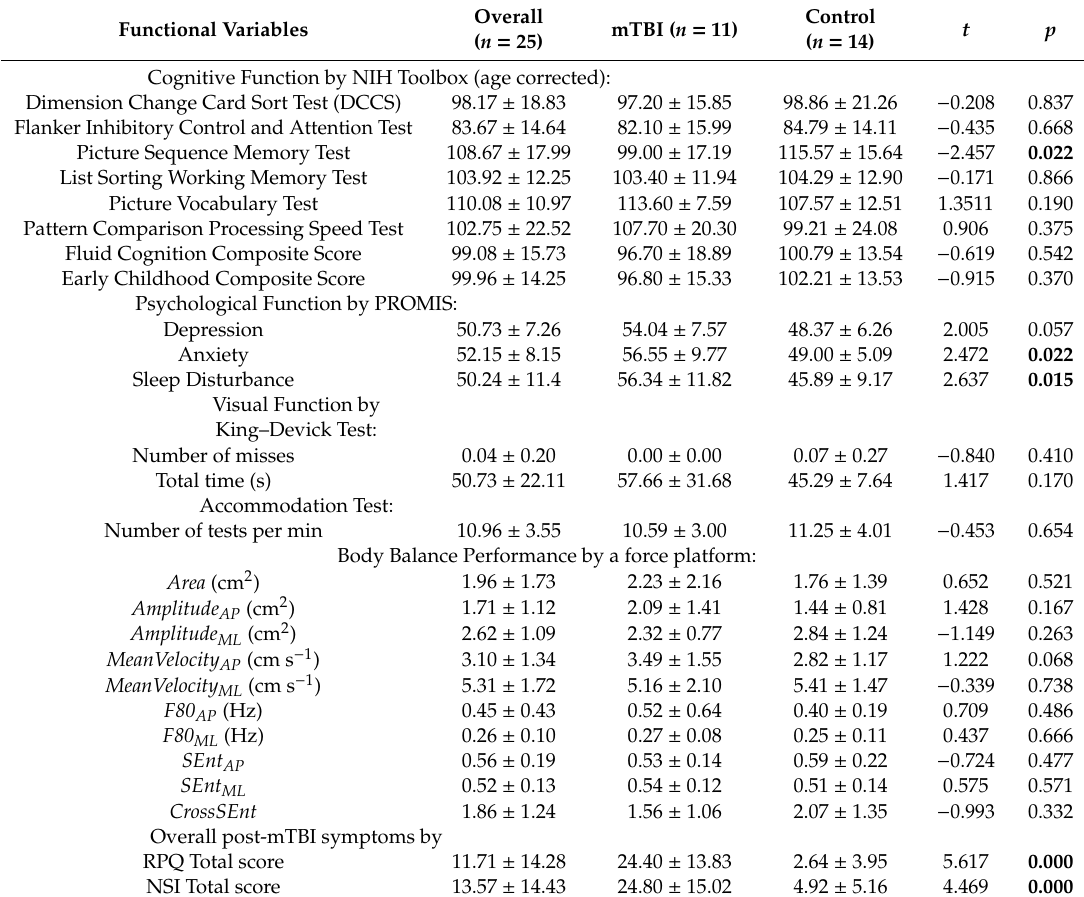
Table 2. Functional di ff erences ( M ± SD ) between mTBI and healthy control college student participants. Functional Variables